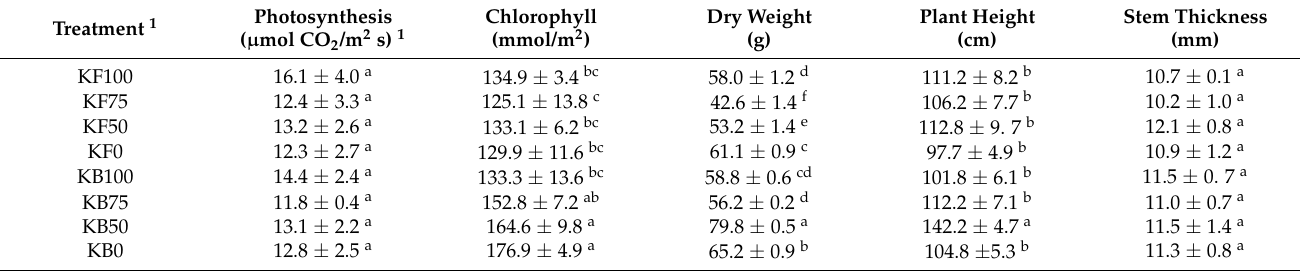
Table 2. Physiological and plant-growth parameters in the evaluation of the biofertilizing effect